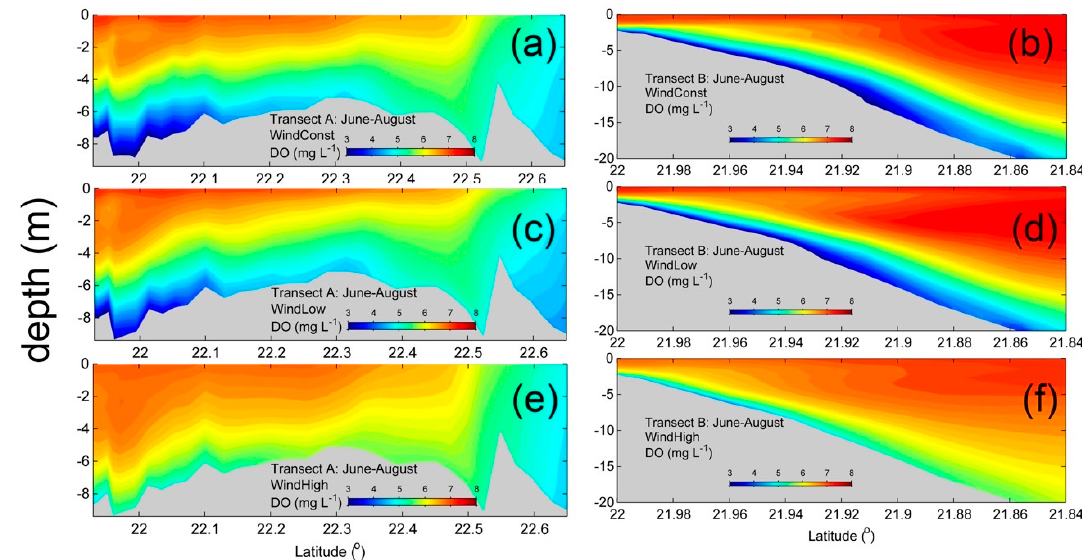
Figure 13. Averaged DO concentrations along two transects for the ( a , b ) WindConst, ( c , d ) WindLow, and ( e , f ) WindHigh model runs.